Question: What form of chart is displayed?
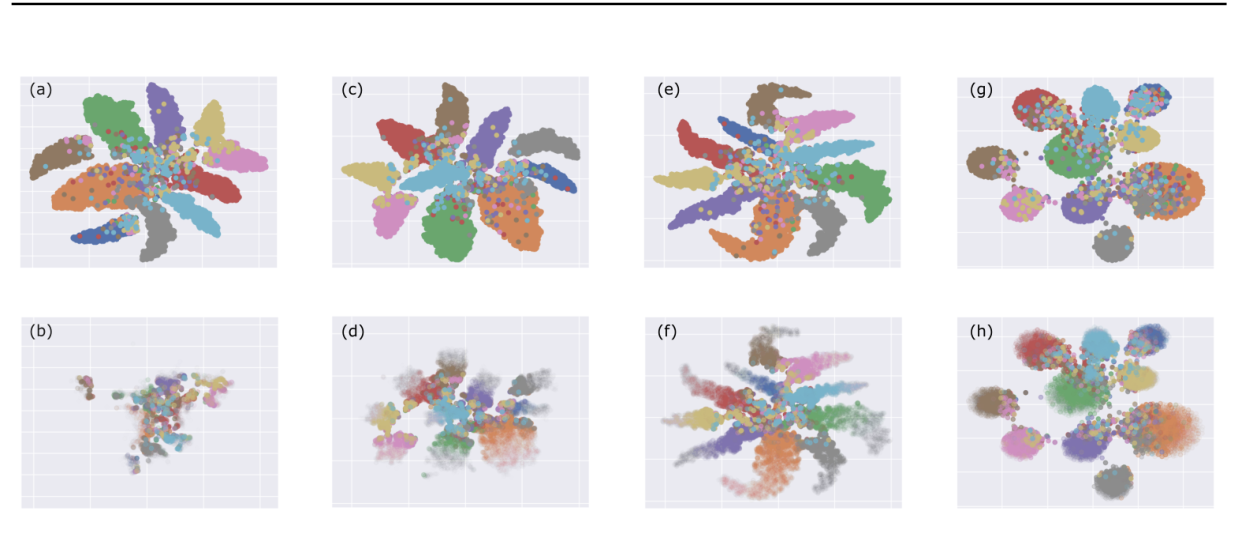
Answer: scatter